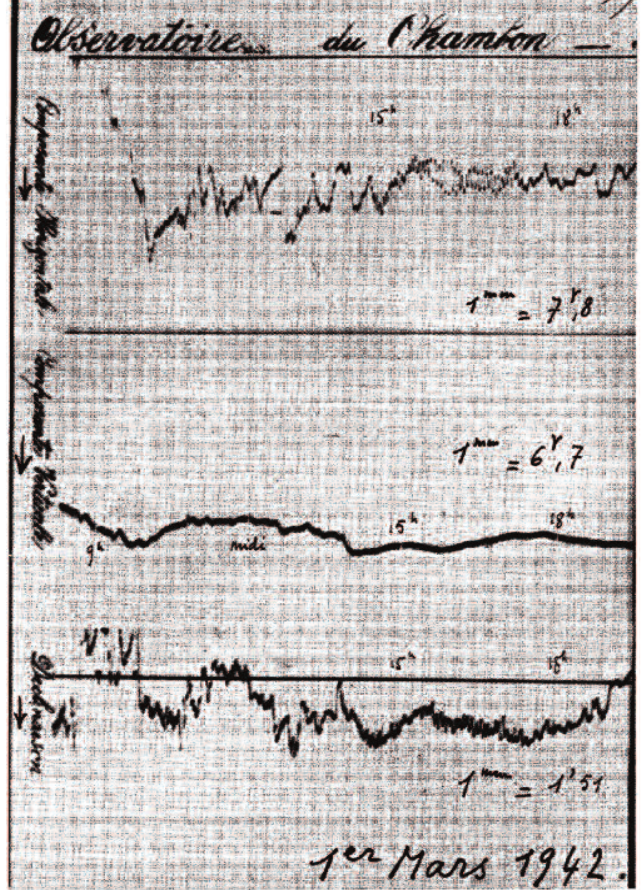
Figure 1. La pulsation géante du 1 er Mars 1952 observée à Chambon-la- Forêt (variomètres